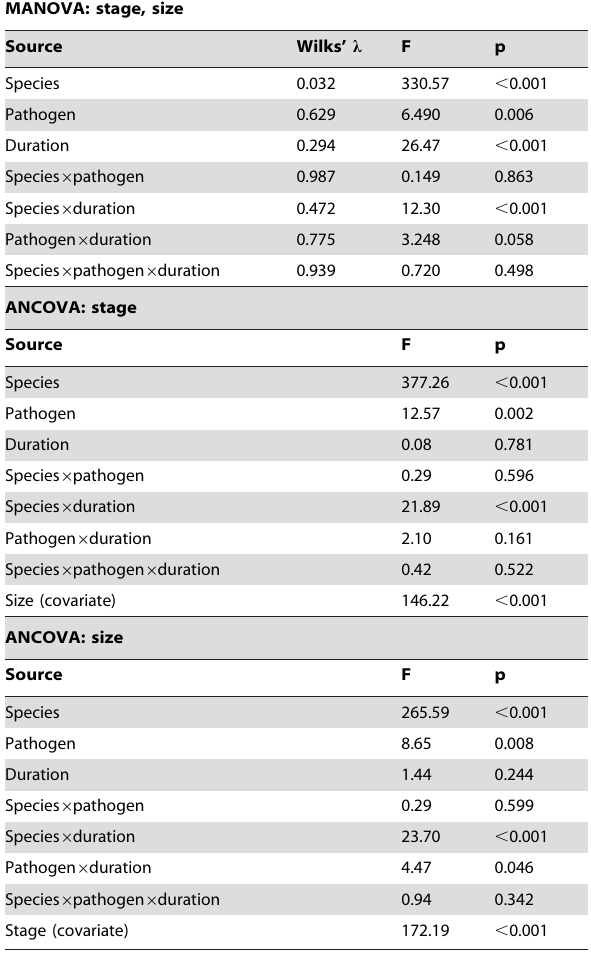
Table 1. Summary of the MANOVA and univariate ANCOVAs for larval stage (Gosner) and size (total length) for single species mesocosms of Anaxyrus fowleri and Hyla versicolor tadpoles reared in the presence of absence of Batrachochytrium dendrobatidis infected tadpoles at two trial